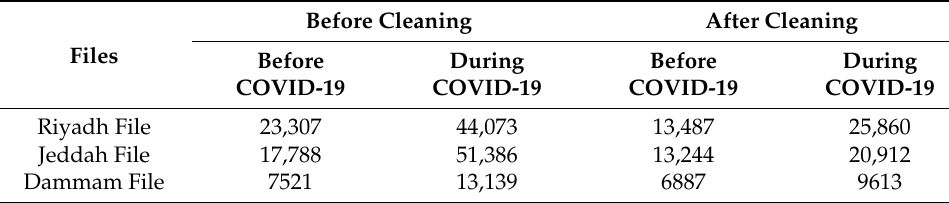
Table 6. Examples for tweets before and after processing. Tweets before Processing Tweets after Processing